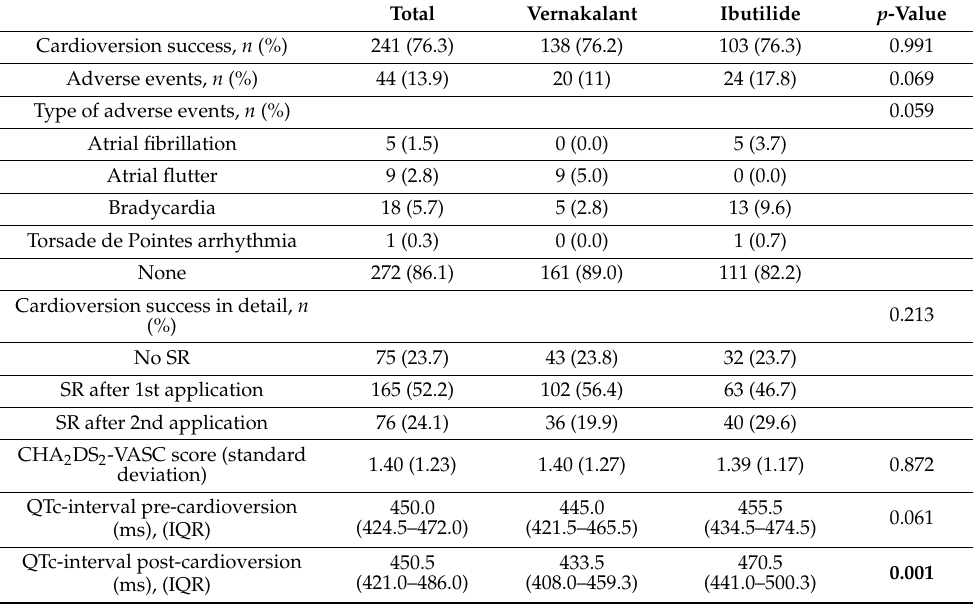
Table 4. Results for the total population.